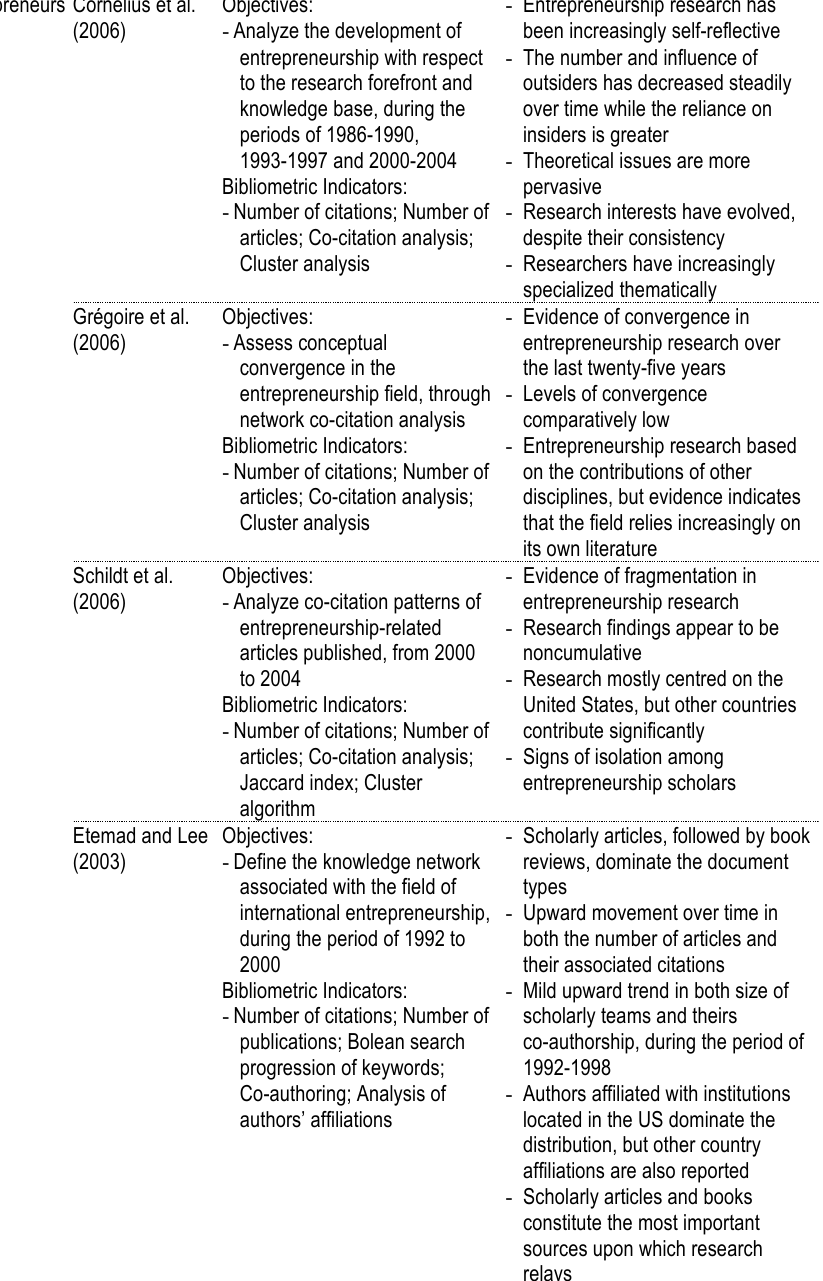
Table A1d . Bibliometric studies – Research Invisible Colleges Application Areas - Research Invisible Colleges